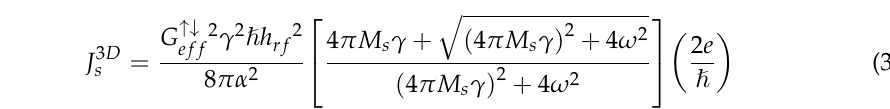
at a thickness of 3 c